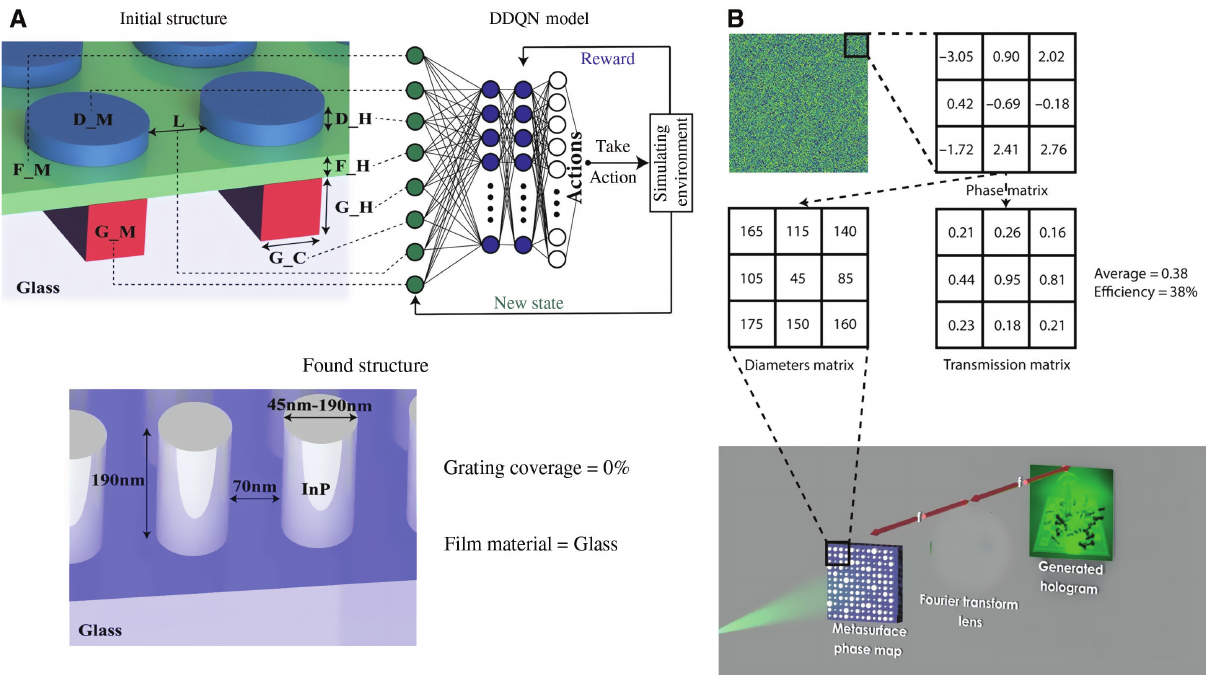
Figure 9: An example of reinforcement learning applied to optimizing a metahologram. (A) A schematic of the initial and optimised structures. (B) The simulated results of the high efficiency metahologram. Figures are reprinted from [97] with permission (CC BY